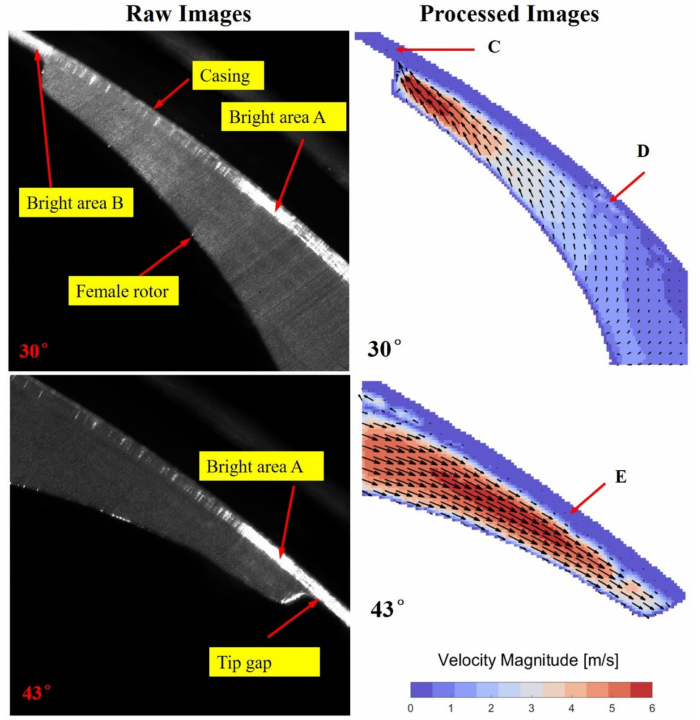
Figure 5. The raw and processed images under the pressure ratio of